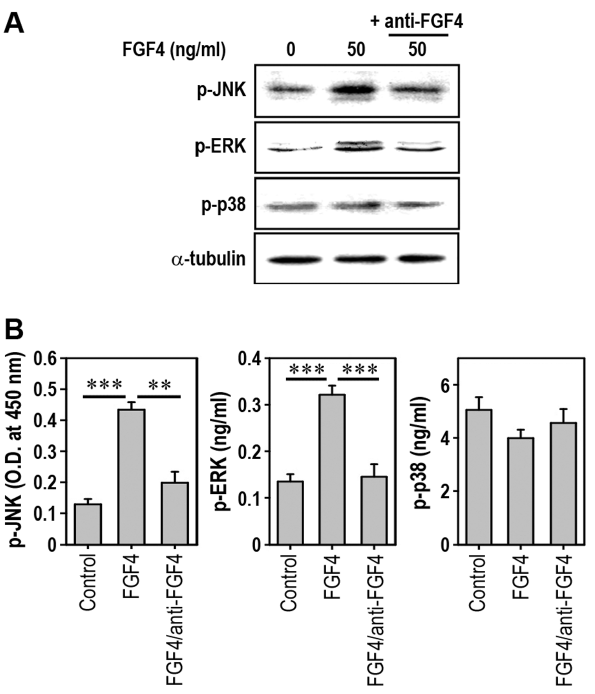
Figure 3. Addition of FGF4 activates JNK and ERK, but not p38 kinase, in mESCs. mESCs cultured in 6-well culture plates were incubated in the presence of 50 ng/ml FGF4 and/or 100 ng/ml anti- FGF4 antibody for 1 h and then processed to determine levels of phosphorylated MAPK by immunoblotting (A) or by immunometric analyses (B). **p , 0.01 and ***p , 0.001 indicate significant differences between experiments.